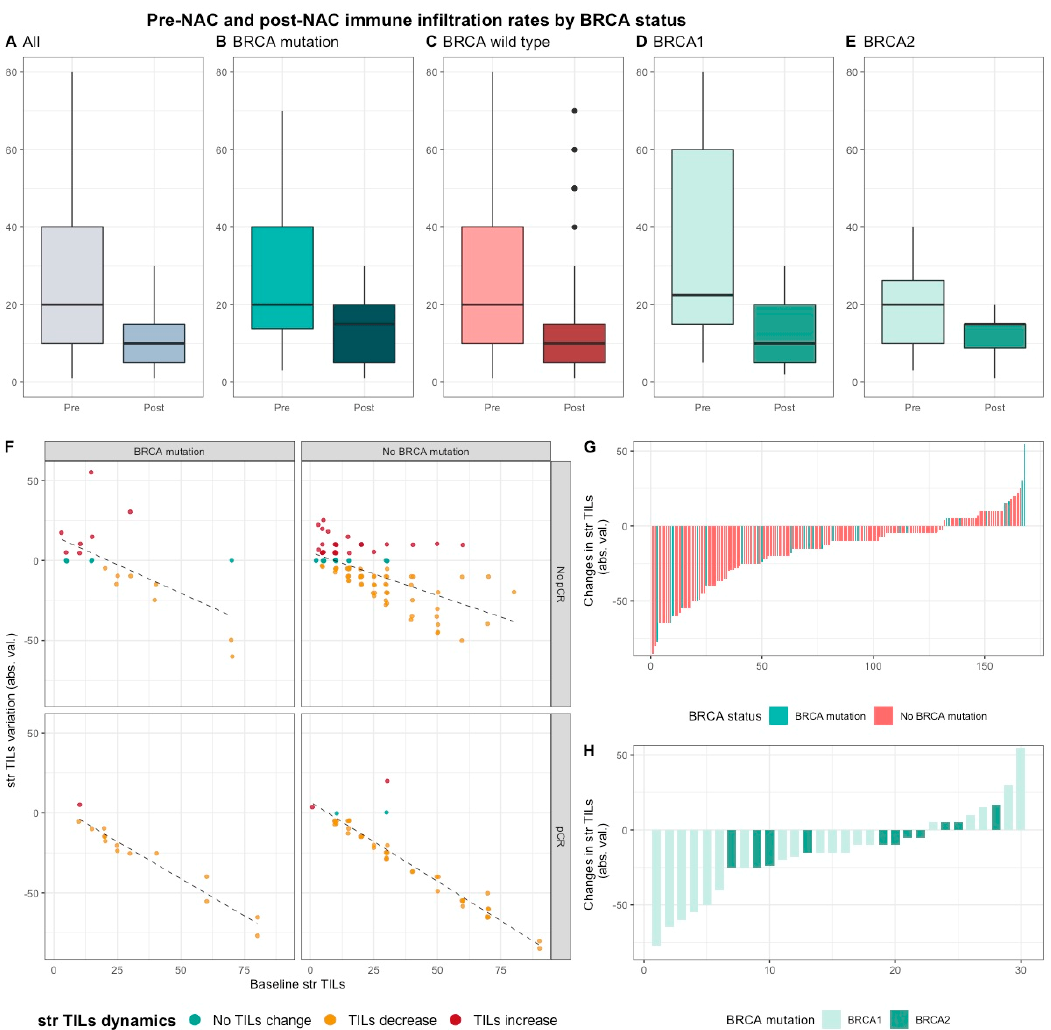
Figure 4. Pre-NAC and post-NAC stromal immune infiltration rates in the whole population and by BRCA status. ( A – E ) bar plots of str TIL levels before and after NAC in the whole population and in BRCA pathogenic variant. Bottom and top bars of the boxplots represent the first and third quartiles, respectively, the medium bar is the median, and whiskers extend to 1.5 times the interquartile range. (All ( n = 192); BRCA mutation ( n = 36), BRCA wild-type ( n = 156); BRCA 1 ( n = 24), BRCA 2 (12)). ( F ) variation of str TIL levels according to the pre-NAC str TIL levels binned by BRCA status and response to chemotherapy. Points represent the difference between pre- and post-NAC paired TIL levels values of a given patient and are colored according to TIL variation category (TIL level decrease: yellow/no change: green/increase: red) (All ( n = 191), BRCA mutation ( n = 36), BRCA wild-type ( n = 155)). ( G – H ) waterfall plot representing the variation of TIL levels according to BRCA -deficient ( BRCA 1-deficient, BRCA 2-deficient); each bar represents one sample, and samples are ranked by increasing order of TIL level change. Paired samples for which no change was observed have been removed from the graph. (All ( n = 191), BRCA mutation [( n = 36), BRCA 1, n = 24; BRCA 2 = 12)], BRCA wild-type ( n = 155)).